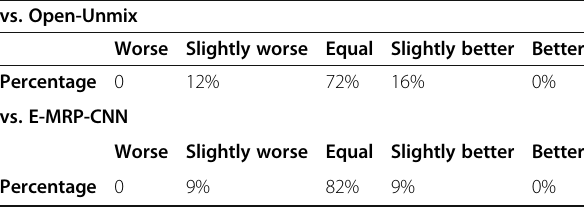
Table 9 Percentages of RPCA-DRNN-separated clips assigned “ worse, ” “ slightly worse, ” “ equal, ” “ slightly better, ” and “ better ” CMOS scores compared with percentages of such scores